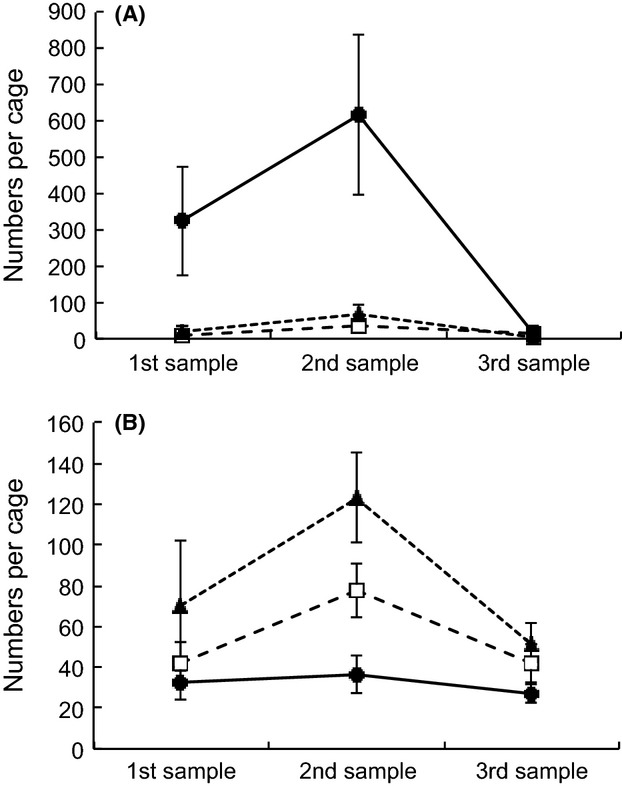
Mean numbers of animals per trap of each litter type on succeeding sampling dates. A = Hypogastrura manubrialis; B = All indigenous species combined. Black dots = yellowbush, Triangles = renosterbos, Squares = Watsonia (Note differences in scale).